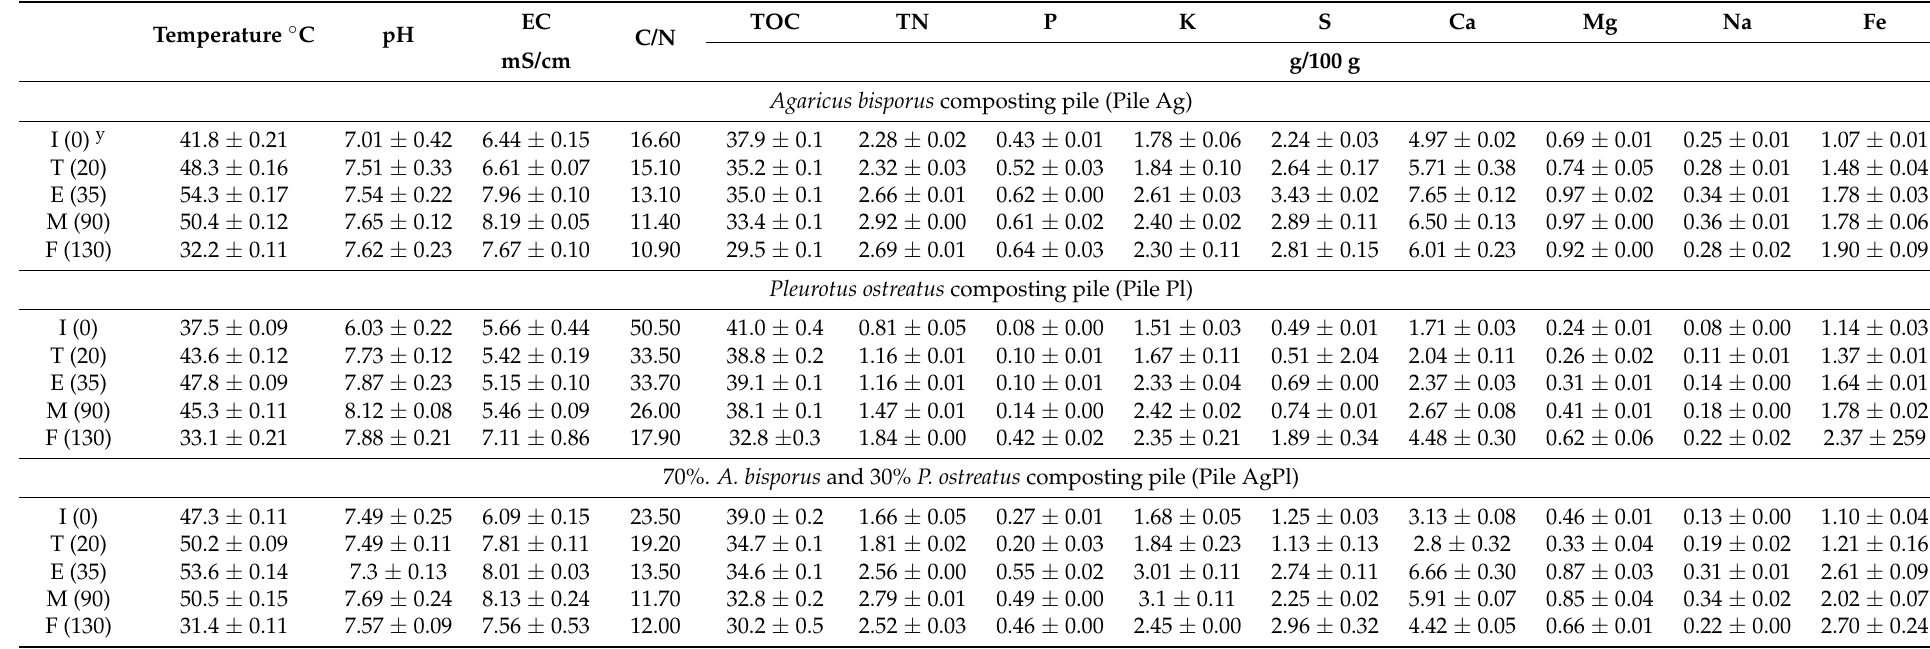
Table 1. Physicochemical and chemical properties during composting